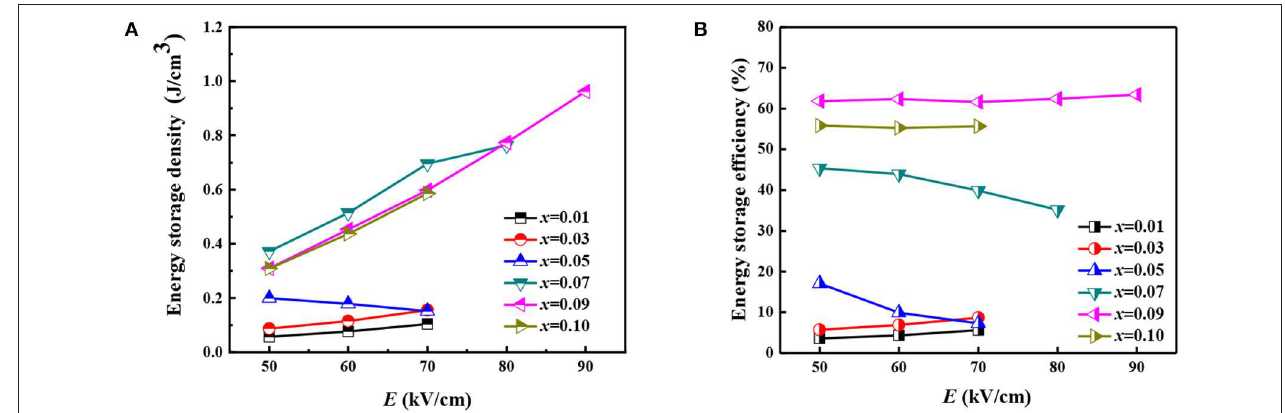
FIGURE 4 | Energy storage (A) density and (B) Efficiency of BNKT- x FSN ceramics under different electric fields.